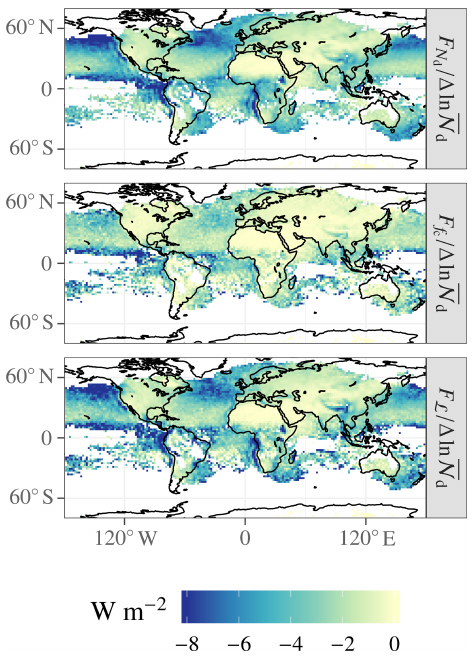
Figure 2. Sensitivity of ERF aci components to anthropogenic N d change (shown only where (cid:49) ln N d > 0 . 05).